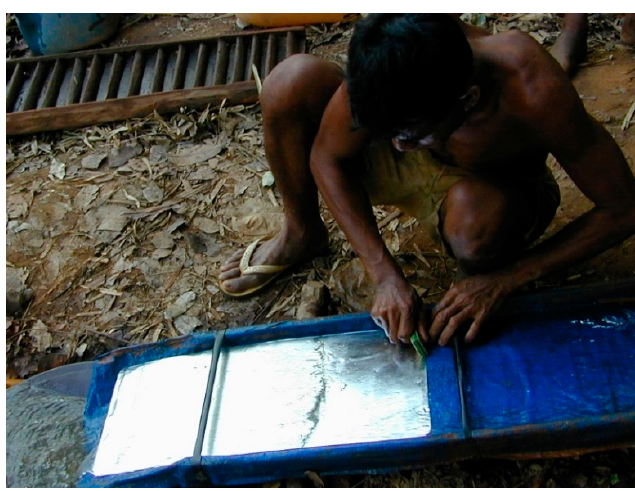
Figure 5. Scraping mercury with gold from flume. (T. Murphy).